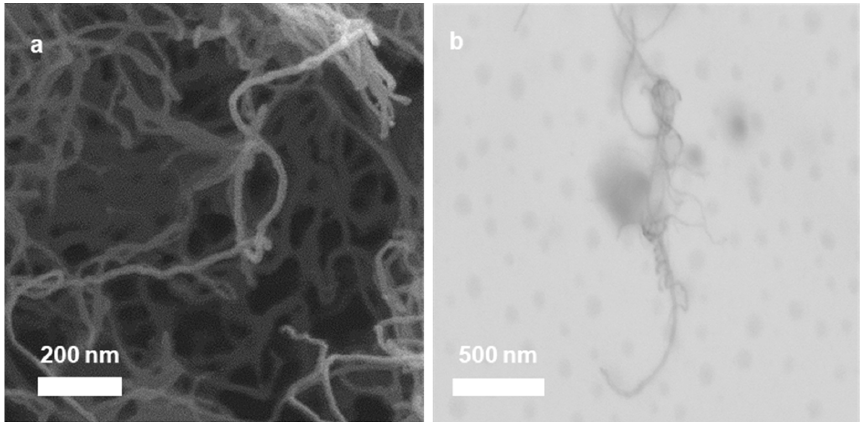
Figure 1. HRSEM micrograph ( a ) and STEM micrograph ( b ) of the carboxylated MWCNT, which were used in the current study.